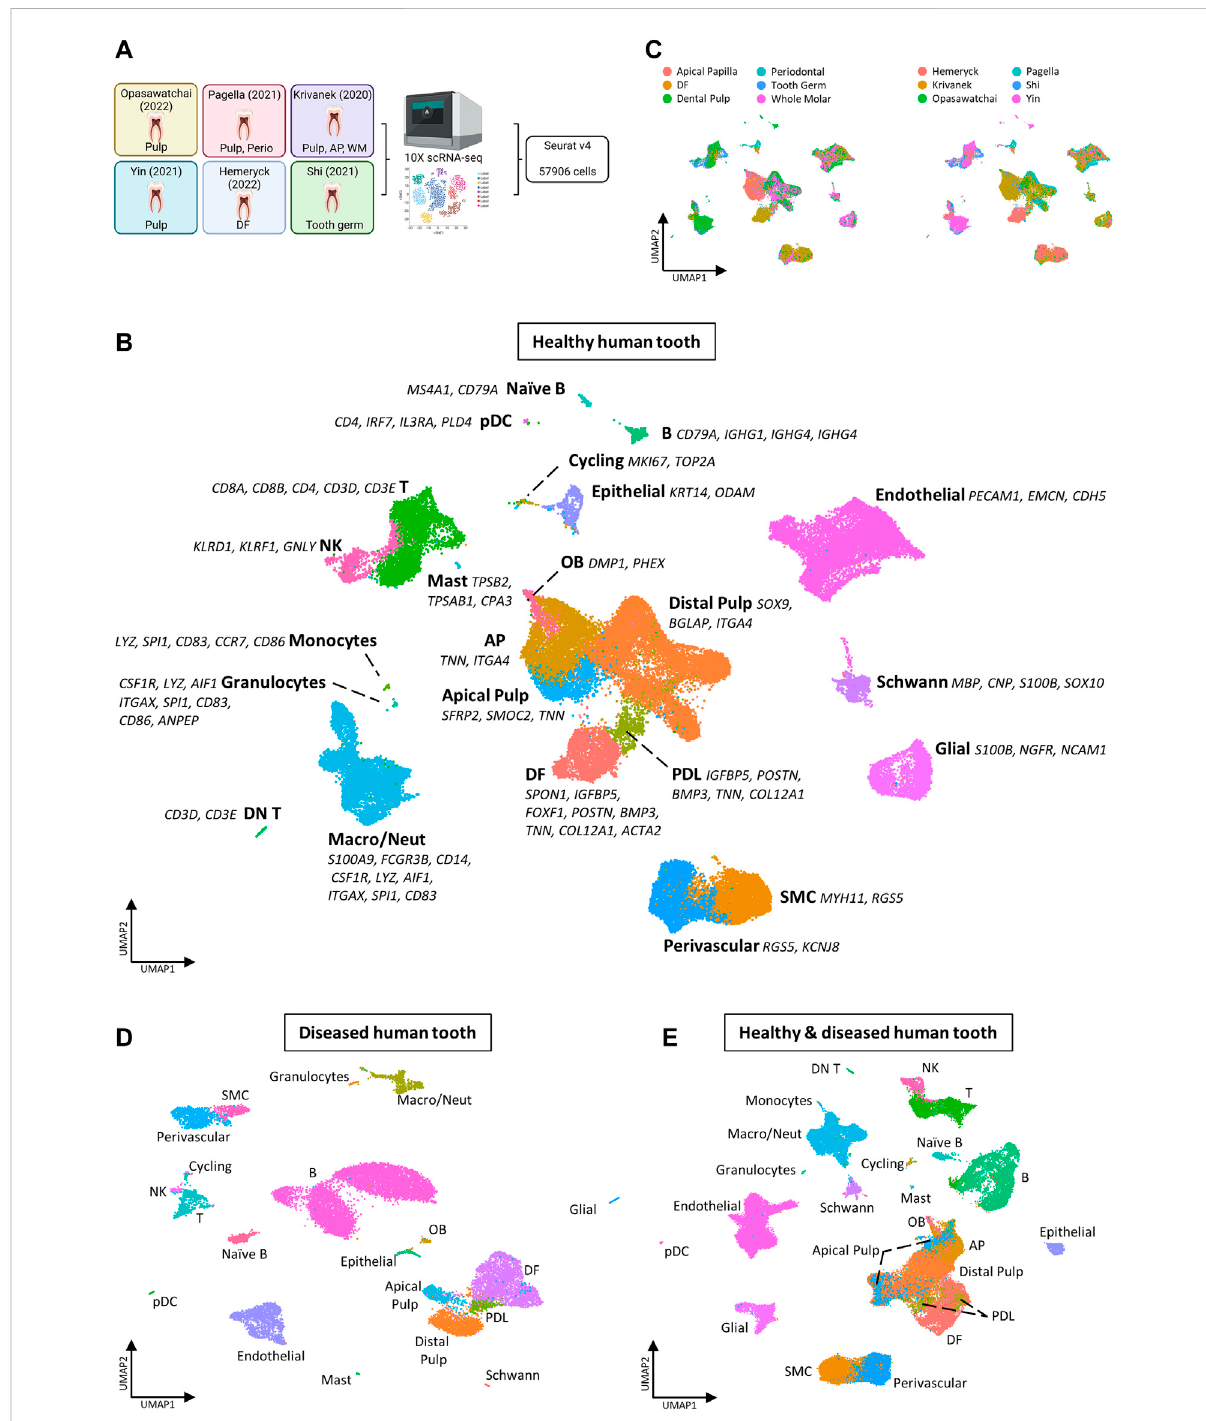
FIGURE 3 Establishment of an inclusive human tooth single-cell atlas. (A) Schematic overview of work fl ow and datasets incorporated in the healthy human toothatlaswith tooth(being molar)and tissue type.Abbreviations:perio, periodontal;AP, apical papilla;WM, wholemolar;DF,dental follicle. (B – E) UMAPplotsoftheannotatedclustersofthehealthyhumantoothatlaswithtopmarkergenesforeachcluster (B) ,oftissuetypeanddataset (C) , of the annotated diseased tooth atlas (D) , and of the integrated healthy and diseased tooth atlas (E)